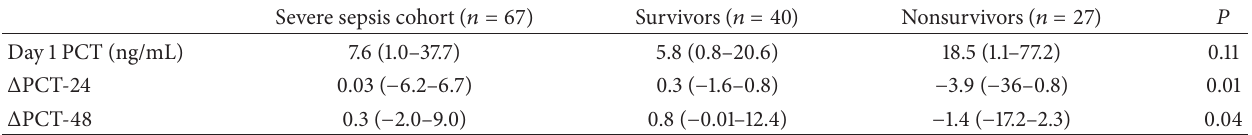
Table 2: PCT as a function of survivors versus nonsurvivors in sepsis